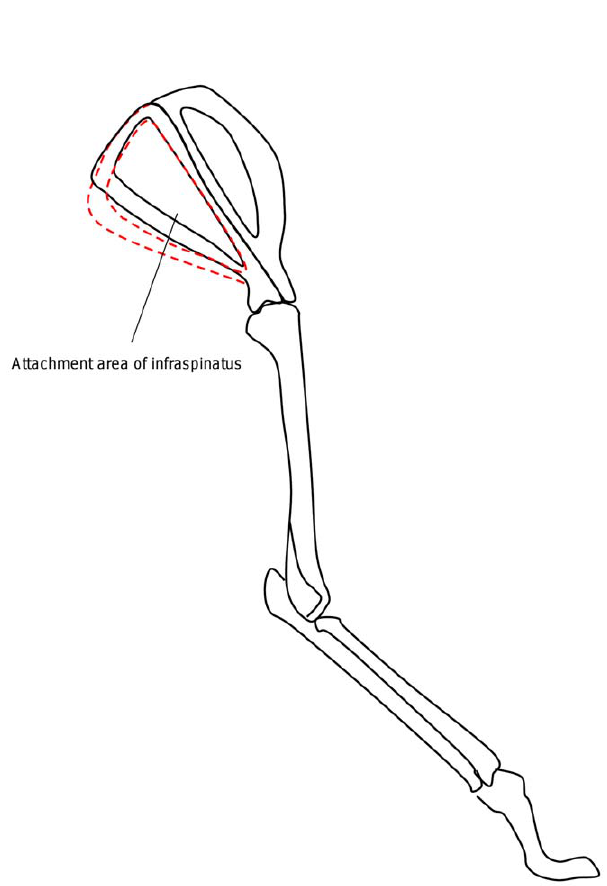
Figure 5. Sketch of a forelimb with different sizes of infraspinous fossa (dotted red sketch is for larger animal).